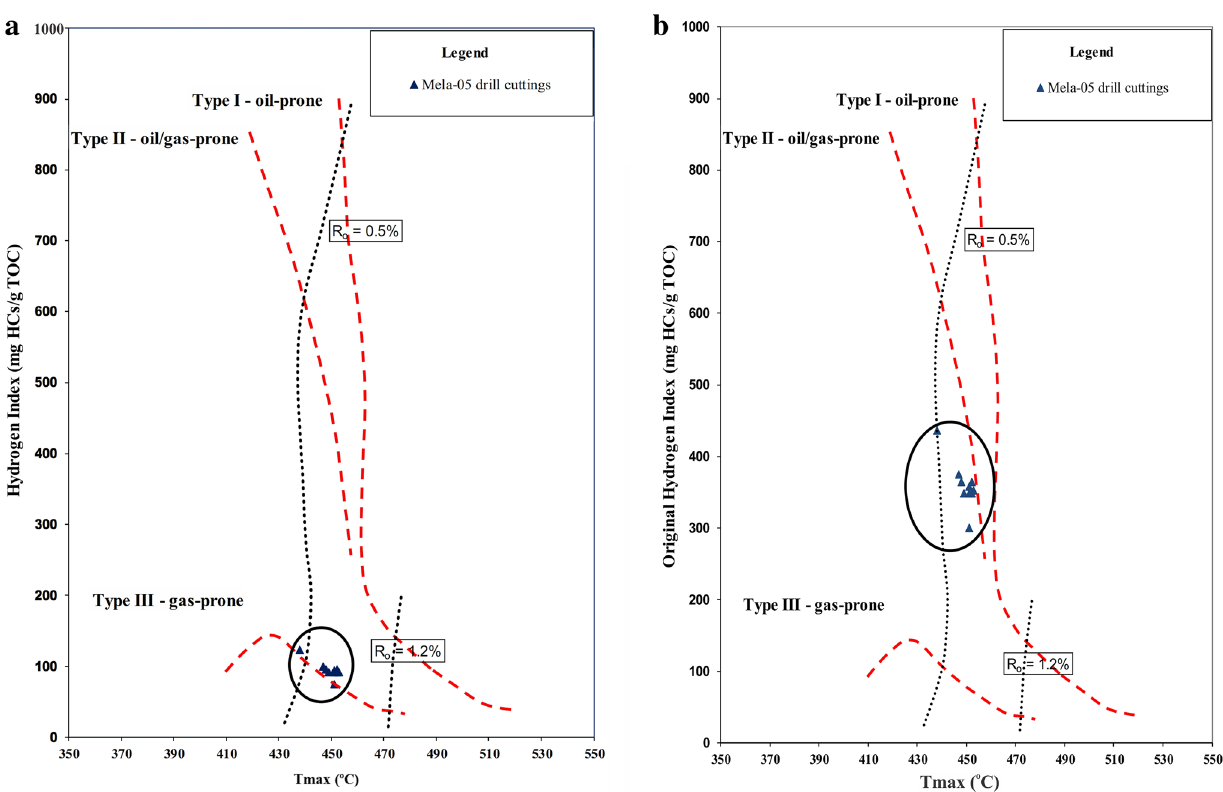
Fig. 4 a The HI versus T kerogen type in Mel-05 drill cuttings of the Chichali Formation (after max cross-plot, showing present kerogen Espitalié et al., type in Mel-05 drill cuttings of the Chichali Formation (after Espi- talié et al. 1986). b The HI o versus T max cross-plot, showing original